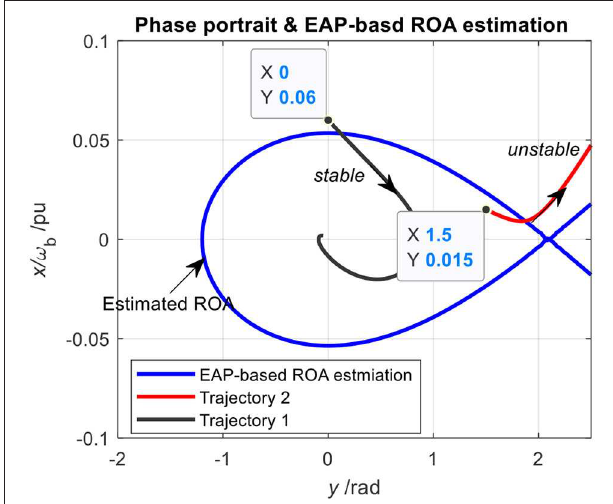
FIGURE 3 | A case where EAP results in an inaccurate ROA ( I ref cd = 1, k scr = 2, α pll =